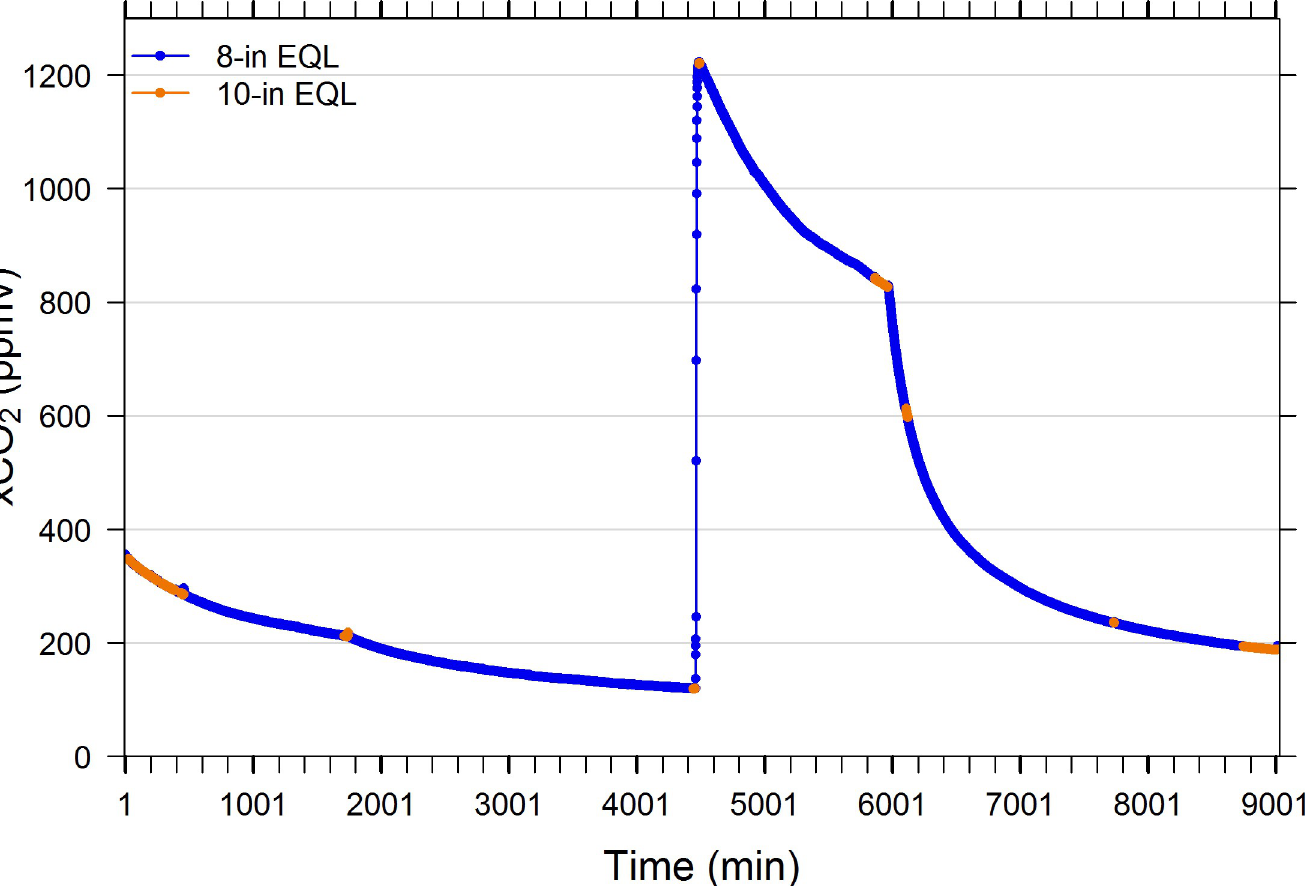
Fig 4. Performance comparison of 10-in and 8-in diameter spherical equilibrators. Common water was pumped continuously to both EQLs throughout the 6-day period and valves connecting sample lines to air pump and IRGA circuit were switched periodically for instantaneous comparisons. Changes in slope are due to increased bubbling of test tank with CO 2 -stripped air. Tank was enriched with compressed CO 2 at minute 4457. See Table 2 for EQL specifications.